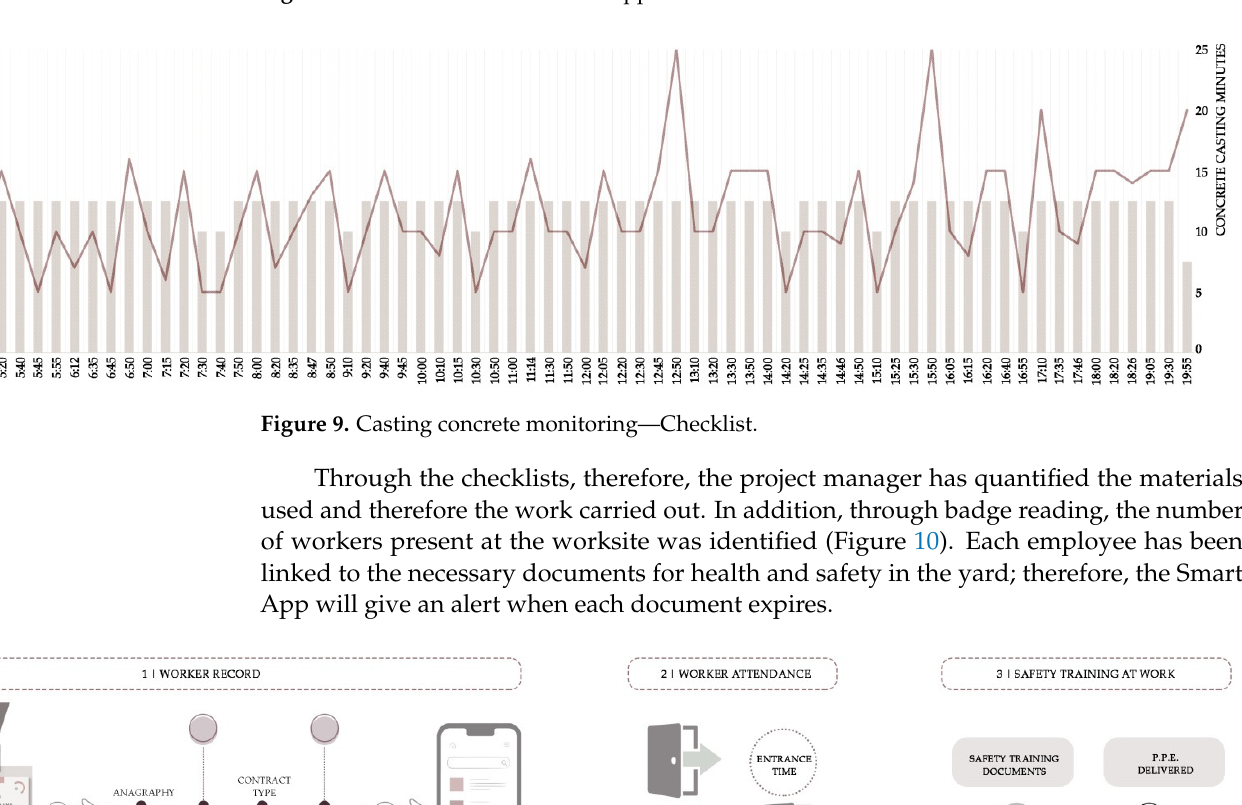
Figure 8. Materials control—SmartApp.